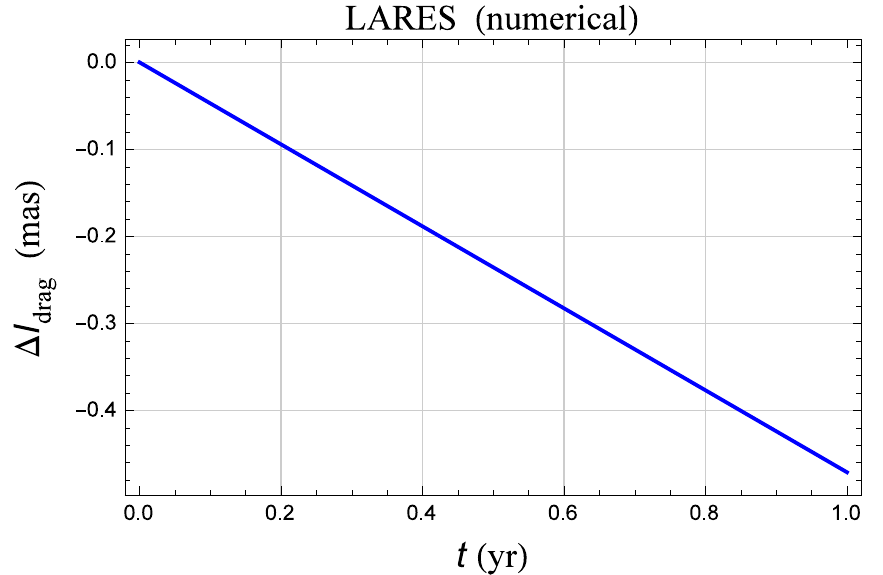
Figure A5. Numerically produced time series of the inclination shift ∆ I drag , in mas, of LARES over a time span T = 1 yr as a result of the difference of two numerical integrations of its equations of motion in Cartesian coordinates with and without the drag acceleration, calculated with the values of the atmospheric and satellite parameters from Pardini et al. [35], sharing the same initial conditions for 6 August 2012 retrieved on the Internet at https://www.calsky.com/. A secular rate of ˙ I LR − 0.5 mas yr − 1 is neatly apparent, in agreement with the analytical result in Iorio